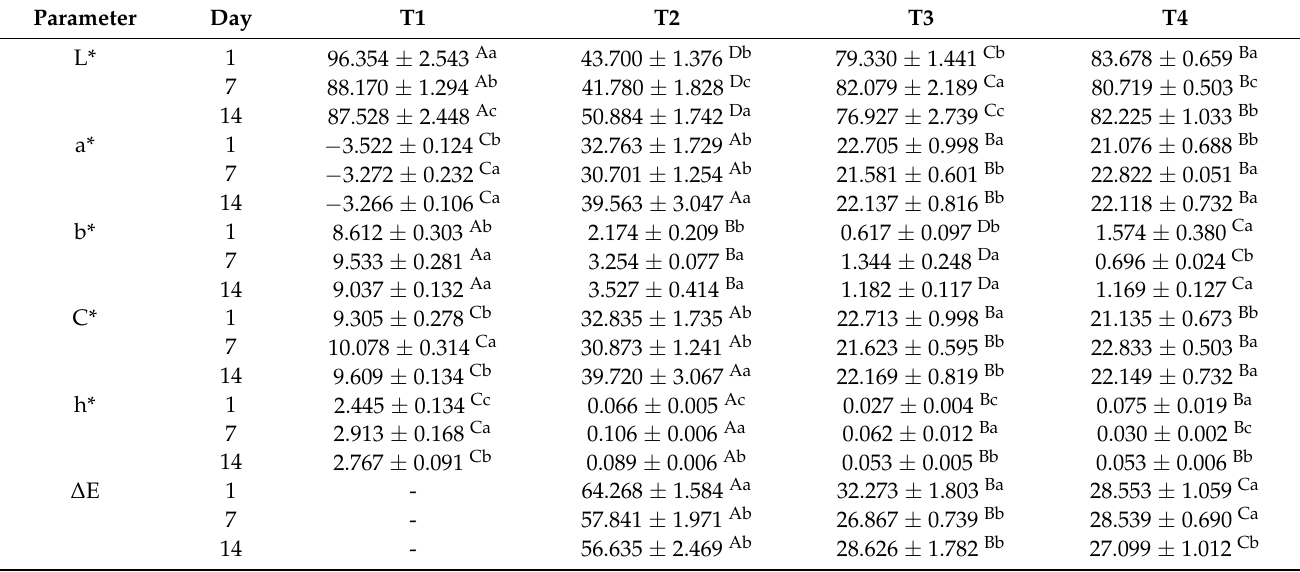
Table 2. Color values L*, a*, b*, C*, h* and ∆ E of yogurt added with liquid extract and lyophilized of beet ( Beta vulgaris sp.).